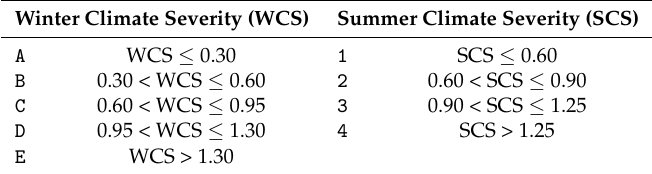
Figure 4. Climatic zones for current thermal building regulation in Morocco (Adapted from [25]). Table 4. Spanish climatic zones based on winter and summer climate severity